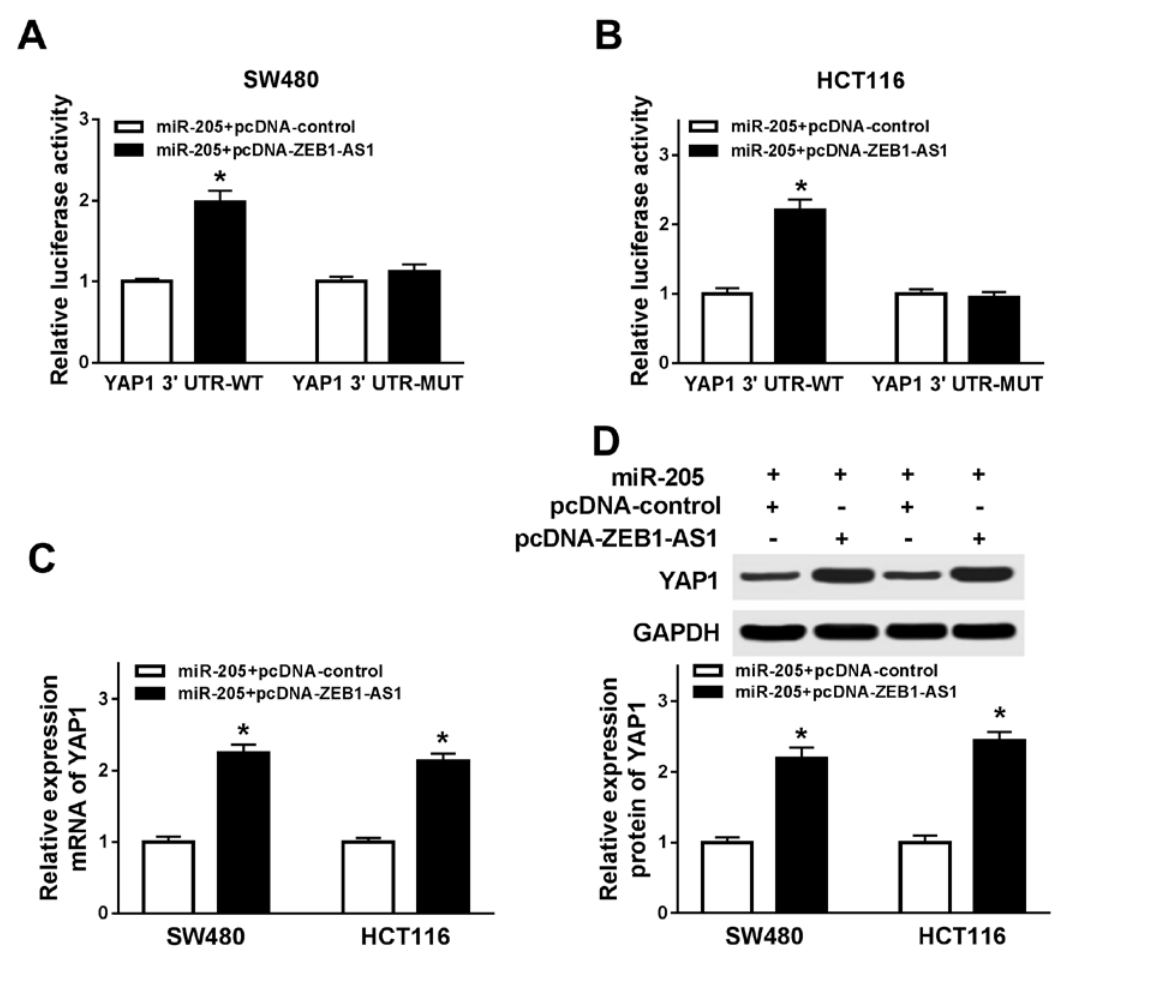
Figure 6: ZEB1-AS1 targeted miR-205 to regulate YAP1 expression (A) Luciferase assay of 3’UTR of YAP1, ZEB1-AS1 and miR-205 in SW480 cells. (B) Luciferase assay of 3’UTR of YAP1, ZEB1-AS1 and miR-205 in HCT116 cells. (C) mRNA level of YAP1 in SW480 and HCT116 cells after overexpression of both miR-205 and ZEB1-AS1. (D) YAP1 protein level in SW480 and HCT116 cells after overexpression of both miR-205 and ZEB1-AS1. * means p <